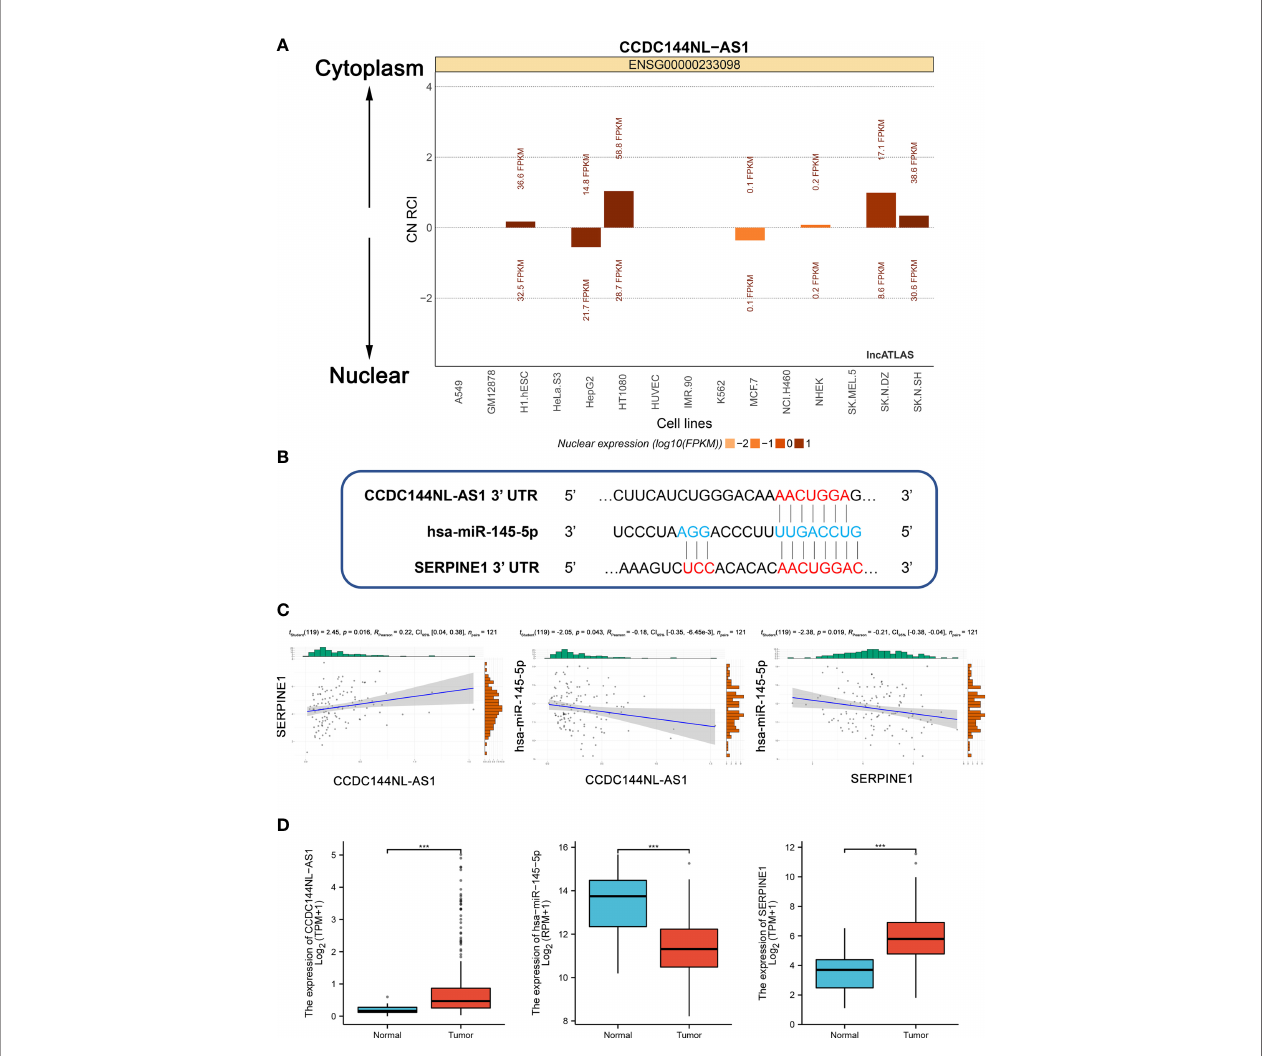
FIGURE 4 | Construction and correlation analysis of the ceRNA network. (A) The cellular localization for CCDC144NL-AS1 was predicted using lncALTAS. (B) Base pairing between hsa-miR-145-5p and the target site in the CCDC144NL-AS1 and SERPINE1 3 ’ UTR predicted by DIANA-LncBase v.2 and TargetScan, respectively. (C) Correlation analysis among CCDC144NL-AS1, hsa-miR-145-5p and SERPINE1 in STAD. (D) The expression levels of CCDC144NL-AS1, hsa-miR-145-5p and SERPINE1. ***p